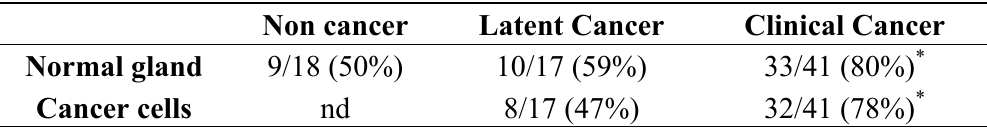
Table 2. The frequency of TSPY expression in prostate specimens. The ratio of TSPY-positive specimens/total are